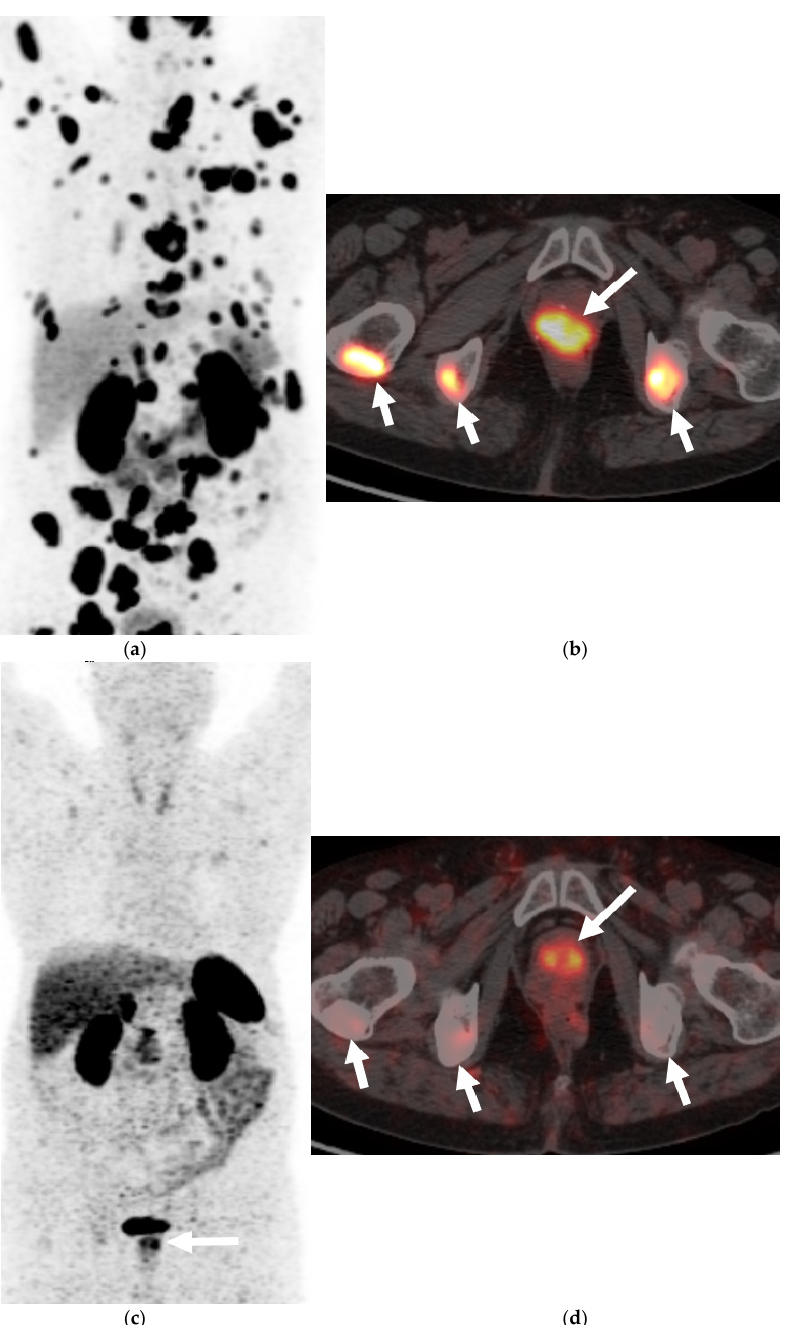
Figure 5. An elderly patient with metastatic neuroendocrine prostate cancer. Coronal maximum intensity projection (MIP) PET image ( a ) and axial color fused image of 68Ga DOTANOC PET-CT ( b ) show intensely hypermetabolic prostatic mass